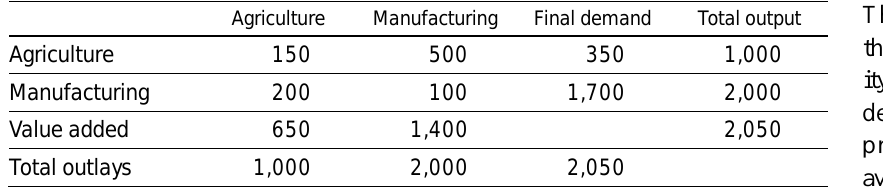
Table 1. Hypothetical Input-Output Transaction